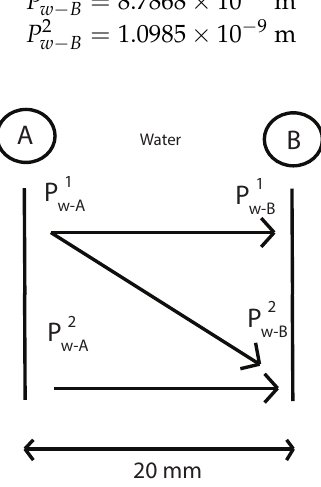
Figure 17. Determination of the geometric attenuation between A and B points without